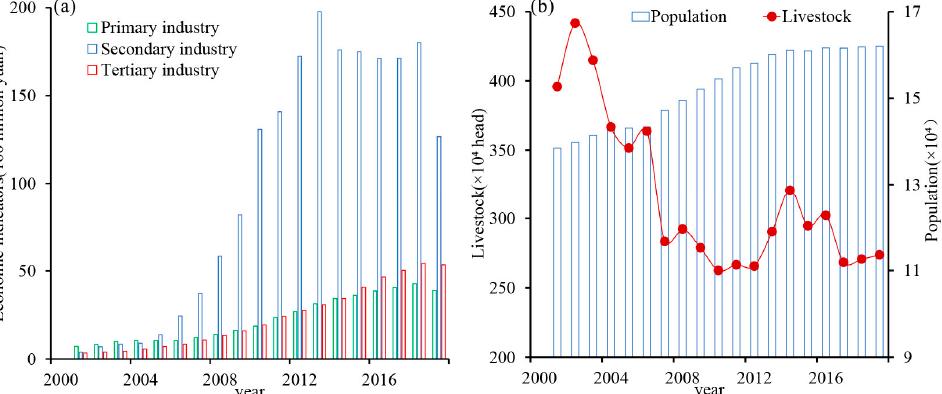
Figure 12. Economic indicators ( a ) and population ( b ) of the URB.